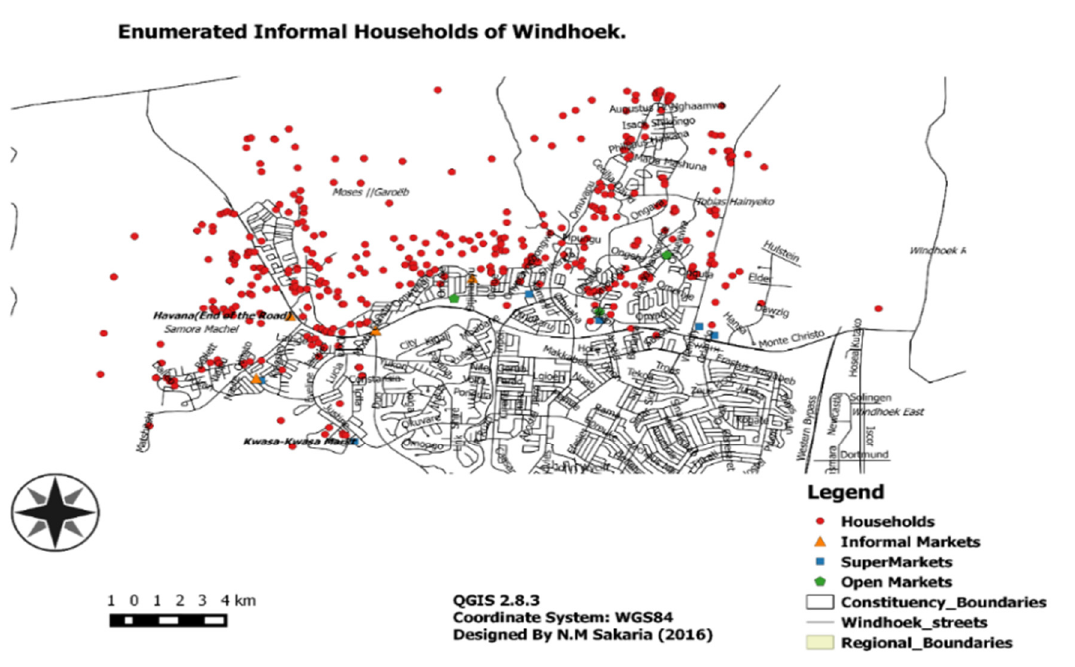
Figure 2. Enumerated informal settlements and households of Katutura, Windhoek. Source: [36].